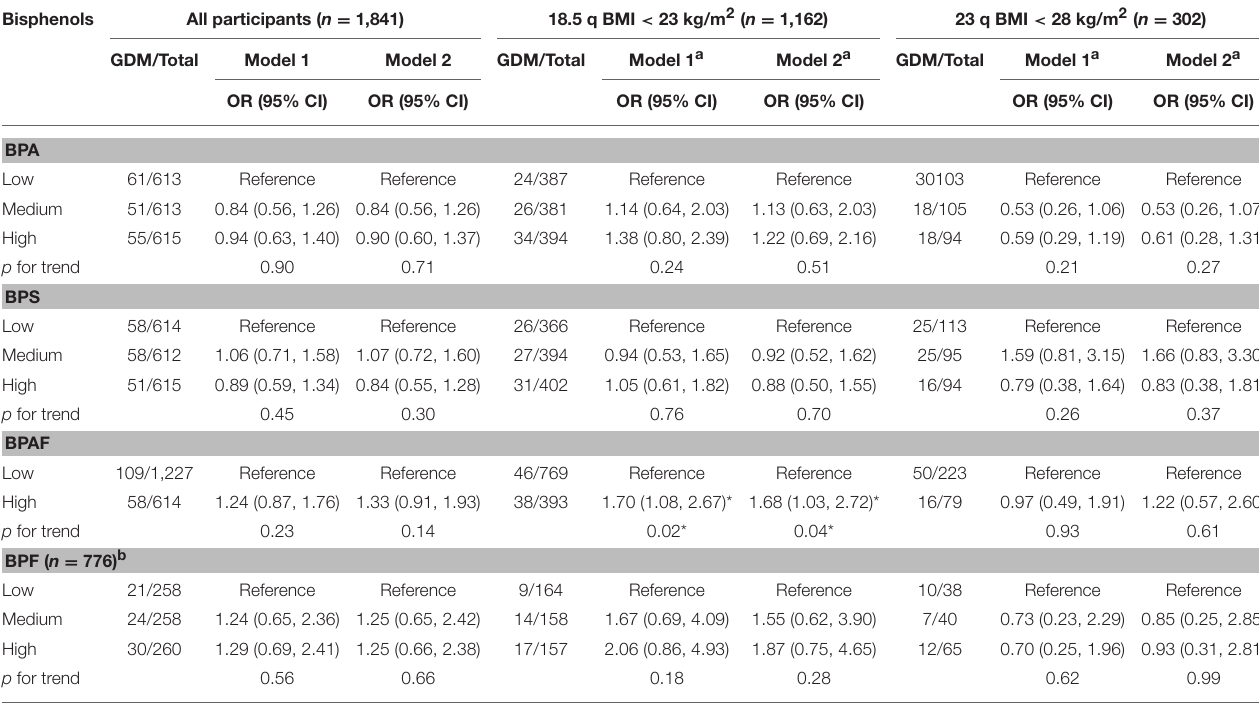
TABLE 3 | Associations of urinary concentrations of bisphenols and GDM.